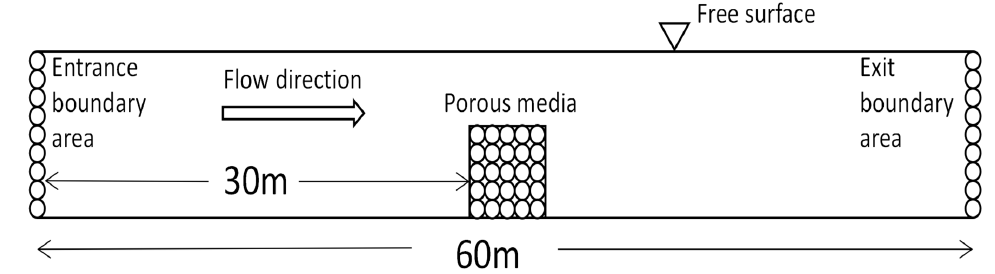
Figure 9. Schematic diagram of numerical water tank.